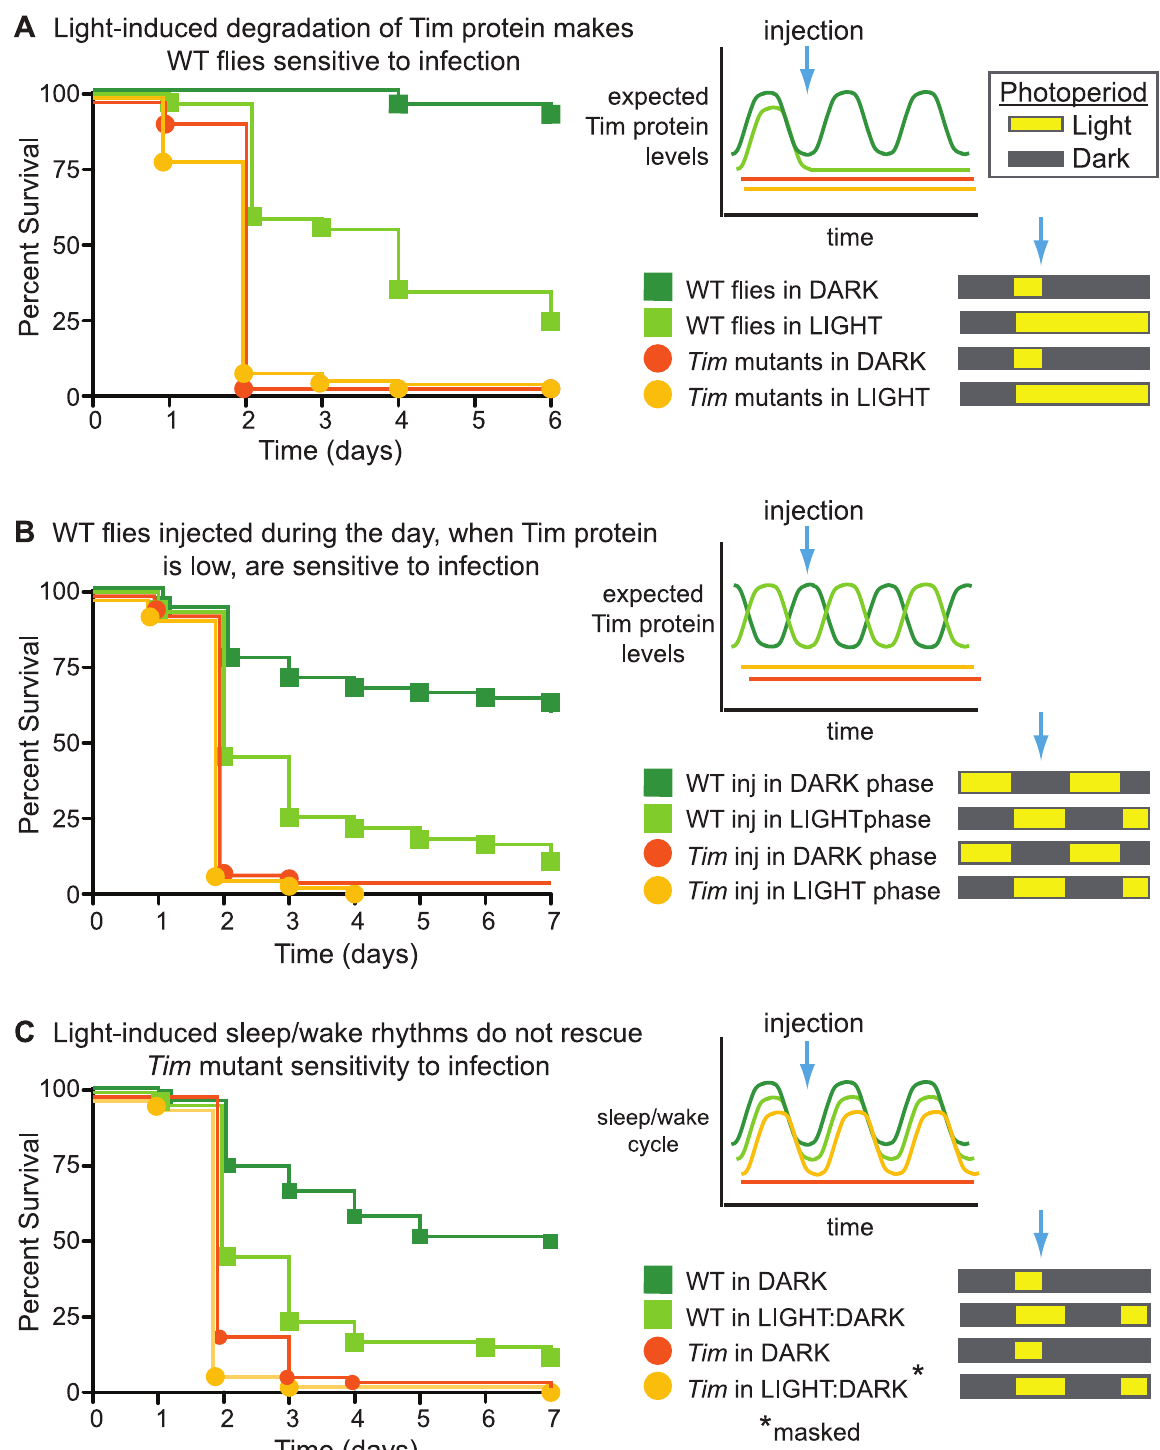
PLoS Pathogens | www.plospathogens.org 5 January 2012 | Volume 8 | Issue 1 |